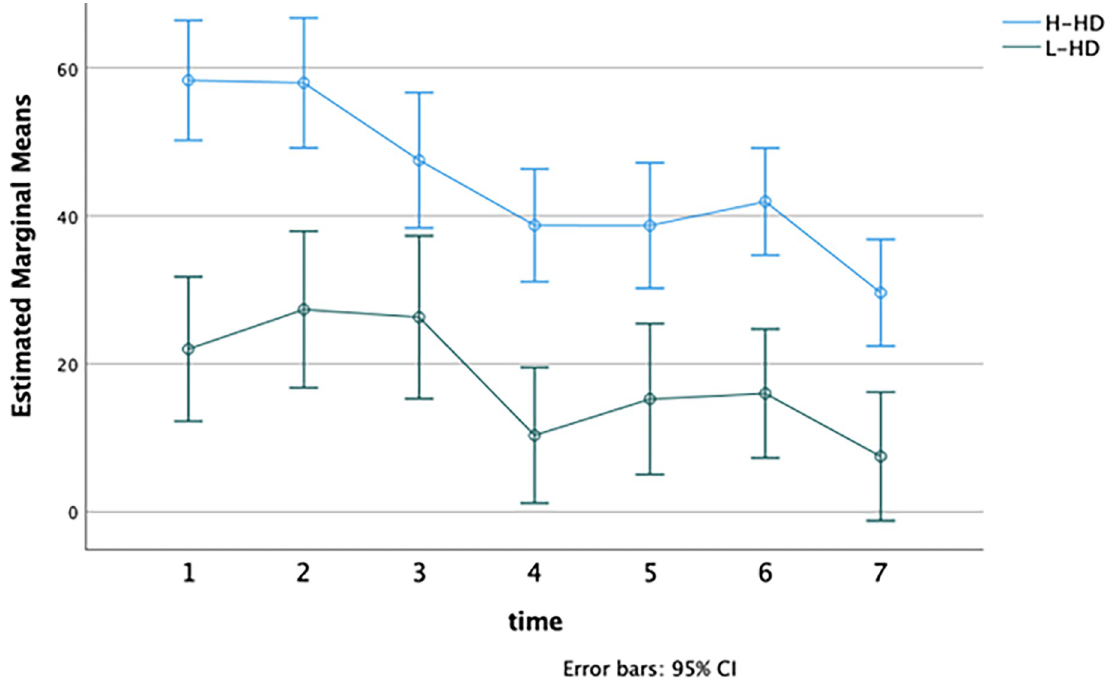
Fig 4. Difference in the level of distress object-related referred each day. Notes : H-HD: group of individuals with higher hoarding features; L-HD: group of individuals without hoarding features; Time 1–7: number of the day.